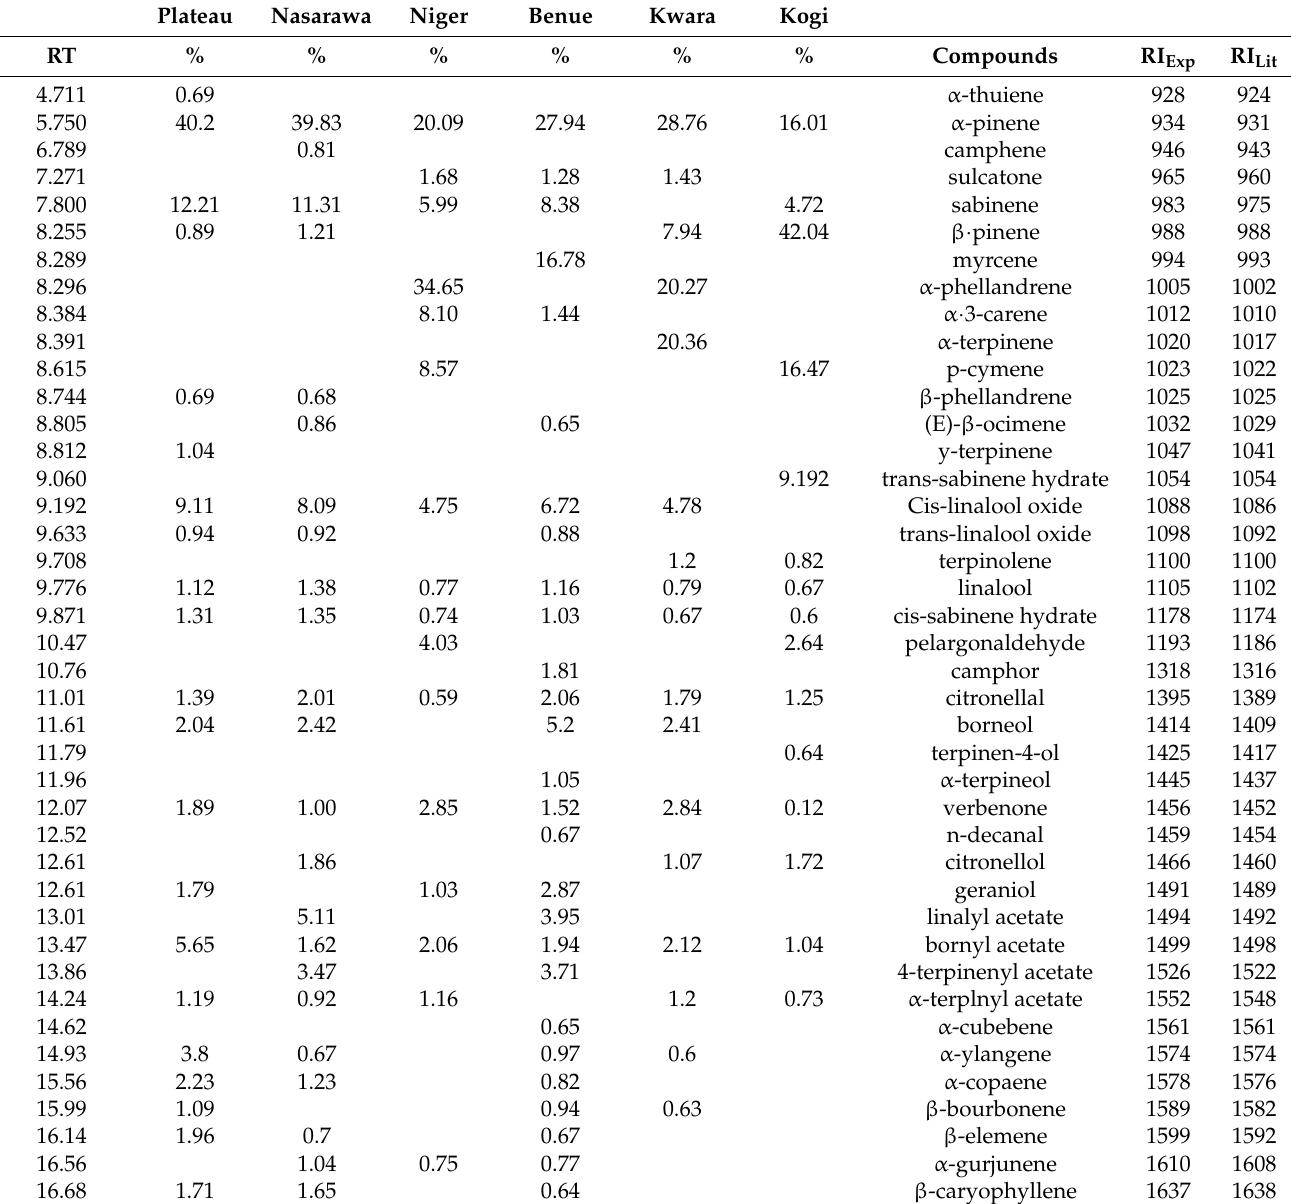
Table 3. Compositional variation in the essential oils of V. negundo from the six study